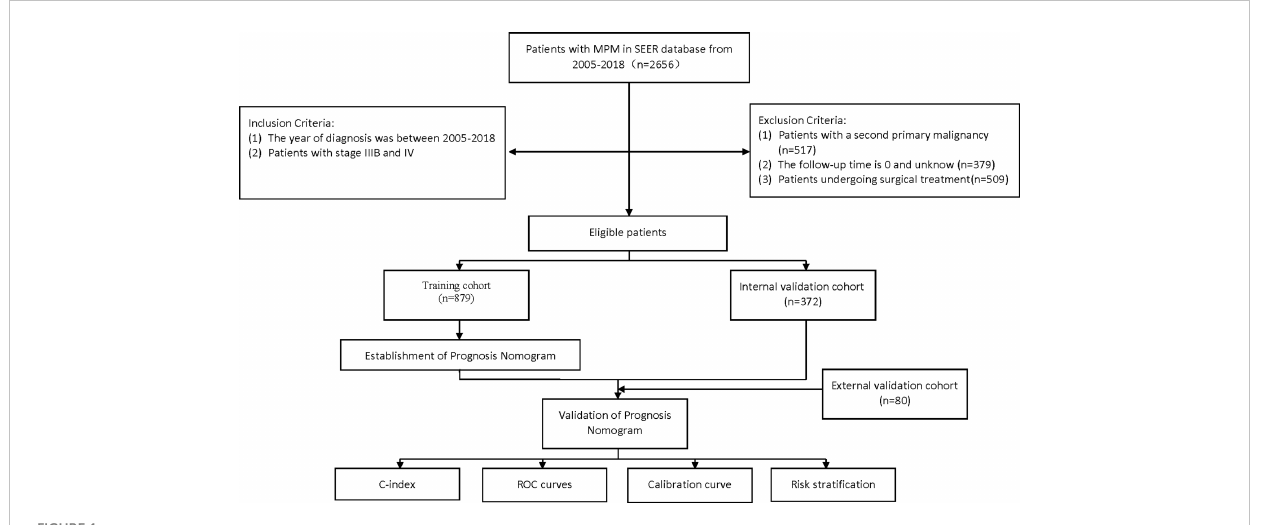
FIGURE 1 Flowchart of participant inclusion and exclusion.